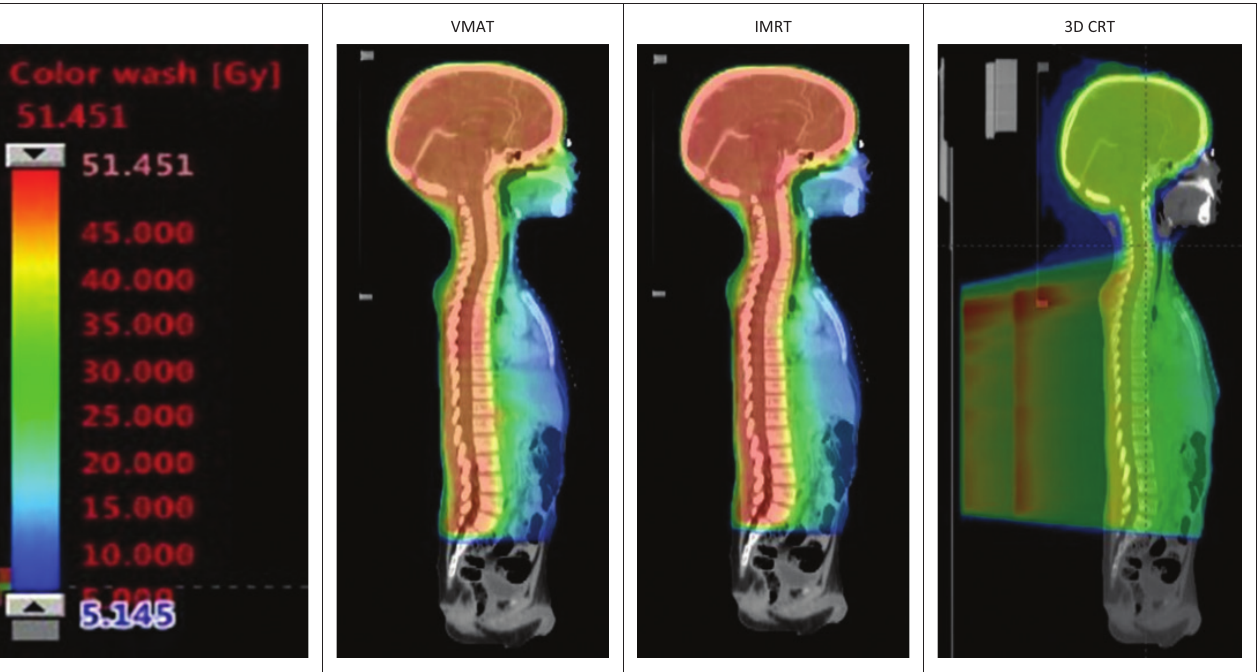
Note: The extended spinal beam for 3D CRT arises from the foam block that is included on top of the treatment couch during 3D CRT treatment. This foam block will not be used for patient positioning during IMRT and VMAT treatment. The dose through the couch structure is not displayed because the couch is not included in the body structure, in contrast to the foam block. IMRT, intensity-modulated radiation therapy; VMAT, volumetric modulated arc therapy; 3D CRT, 3D conformal radiation therapy. FIGURE 5: Colourwash planned target volumes dose